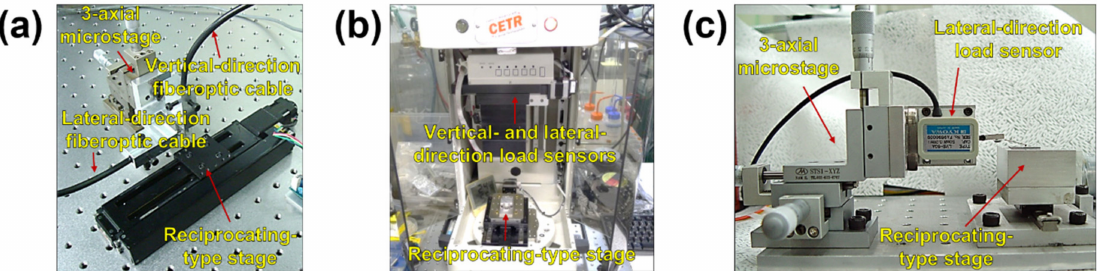
Figure 4. Images of ( a ) custom-built tribotester with two fiberoptic sensors and a cantilever tip; ( b ) commercial tribotester (CETR) consisting of two load sensors; ( c ) Custom-built micro-tribotester comprising a load